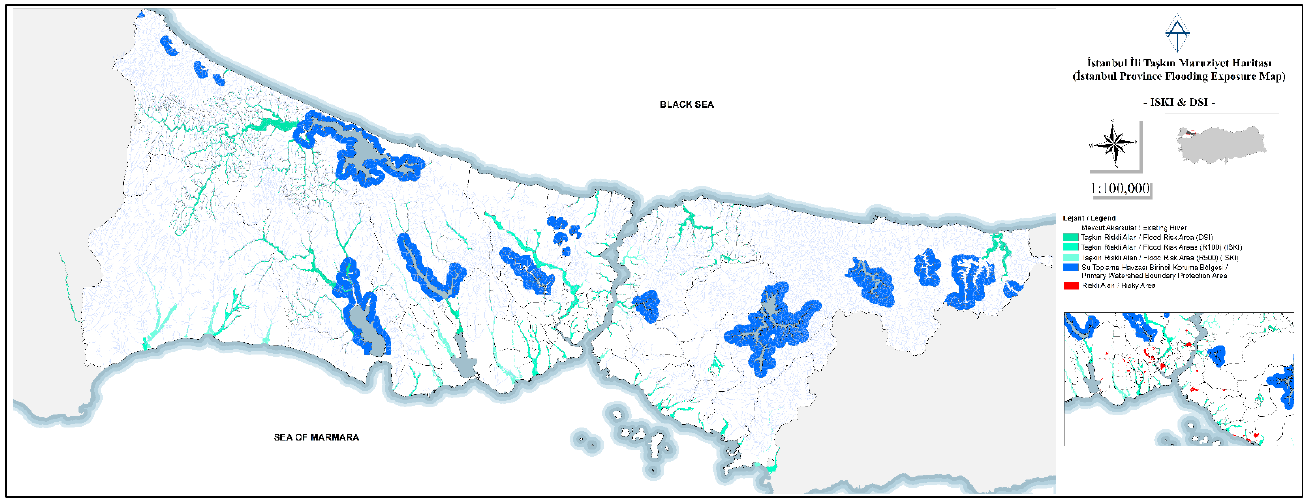
Figure 11. Istanbul Province Flooding Exposure Map (DSI & ISKI).